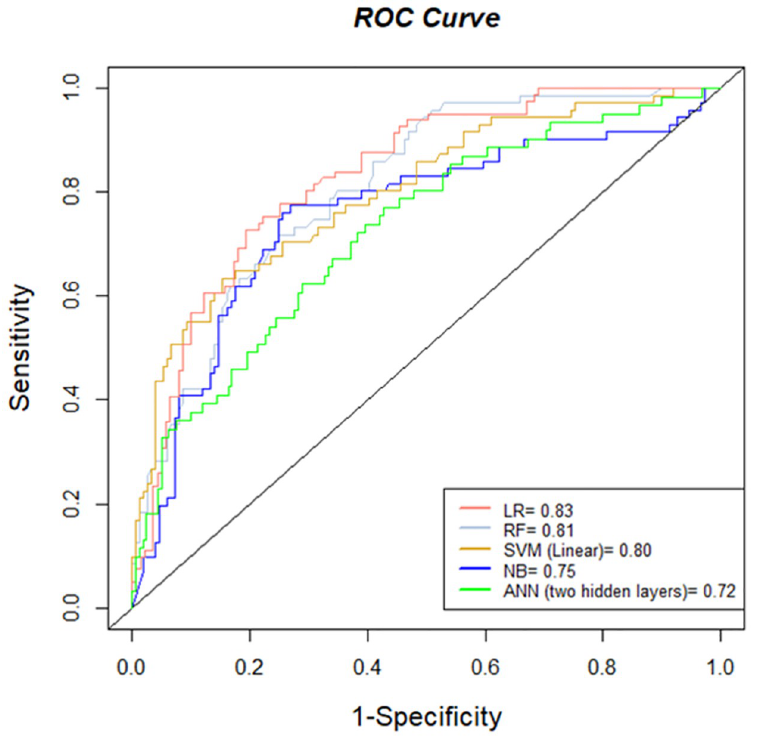
Fig 6. ROC curve and AUC for the best-performing model of different approaches.